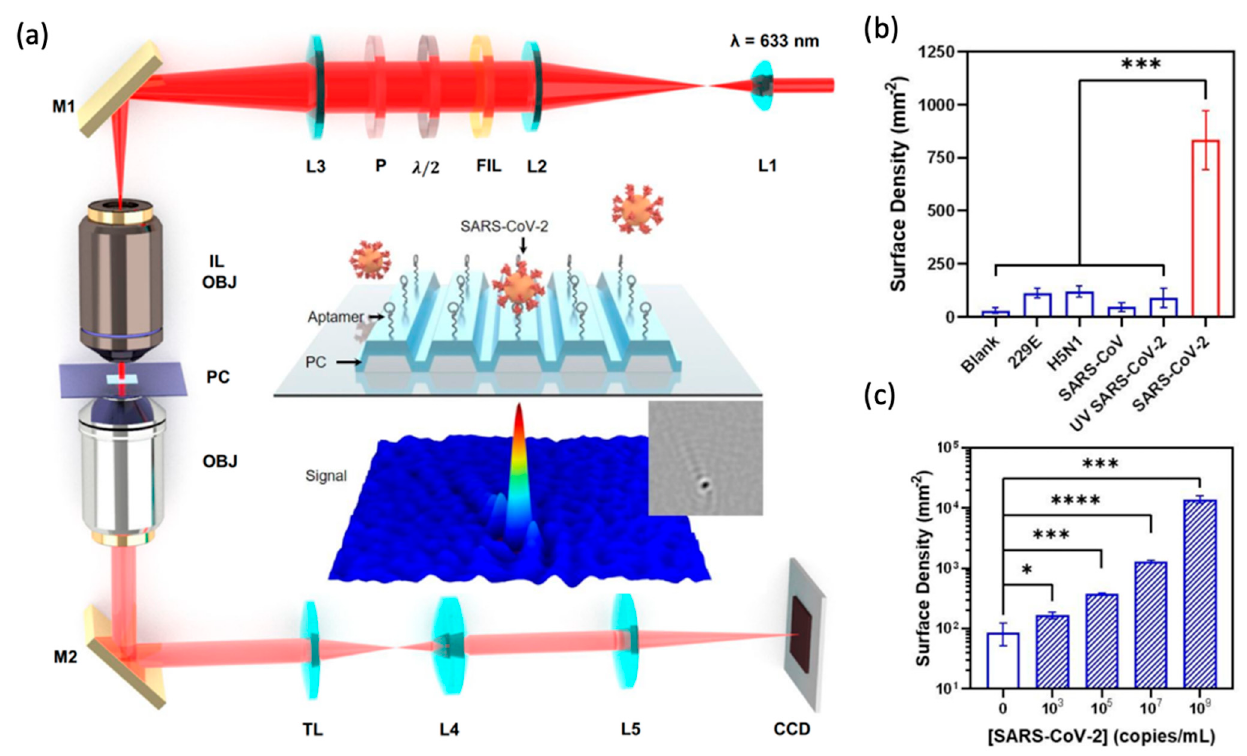
Figure 5. Metamaterial-Enhanced Interferometric Scattering Microscopy ( a ) Schematic of the photonic resonator interferometric scattering microscopy (PRISM) instrument. Inset: detection scheme for label-free detection of pseudotyped SARS-CoV-2 using DNA aptamers. ( b ) Selectivity and ( c ) sensitivity of the PRISM-based SARS-CoV-2 biosensor. Error bars represent the standard deviations of at least three independent measurements. ( * significant; ** very significant; *** and **** extremely significant. ) Reprinted from Ref. [71].